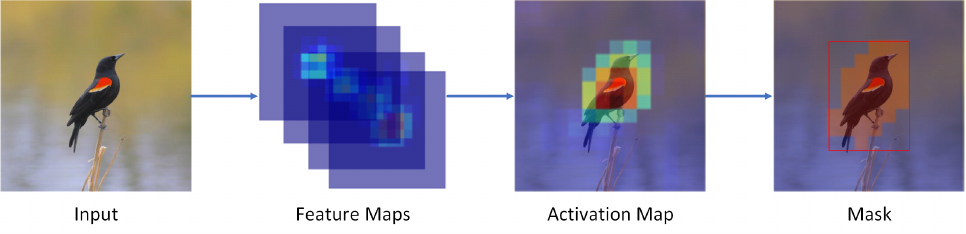
Figure 2. In the process of the object area localization, we first obtain the raw image’s attention map by overlaying the raw image’s feature map with channels. Then, we obtain the target bounding box based on the distribution of the attention values in the attention